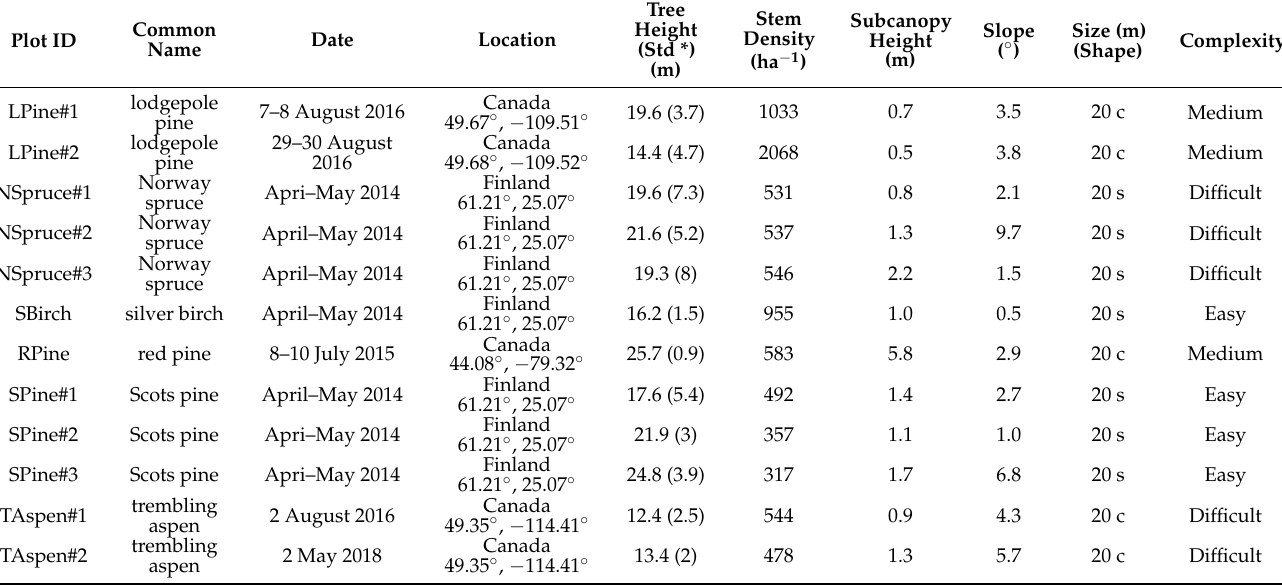
Figure 3. treeiso ’s workflow.